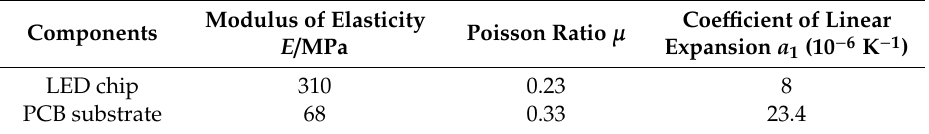
Table 11. Material parameters of the LED chip and PCB substrate.